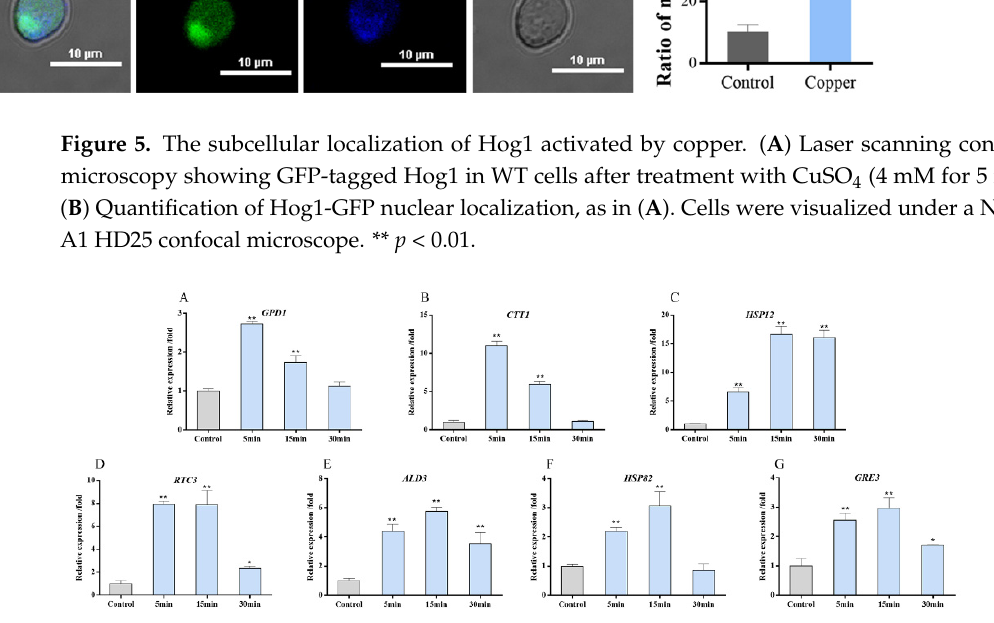
Figure 6. The expression profiles of HOG genes in response to copper: relative expression levels are shown for ( A ) GPD1 , ( B ) CTT1 , ( C ) HSP12 , ( D ) RTC3 , ( E ) ALD3 , ( F ) HSP82, and ( G ) GRE3 genes of the WT strains after treatment with 4 mM CuSO 4 . The mRNA levels of these genes were normalized to that of the ACT1 gene in the same sample. Mean ± SD values are from three independent experi ‐ ments. Asterisks indicate * p < 0.05 and ** p < 0.01.